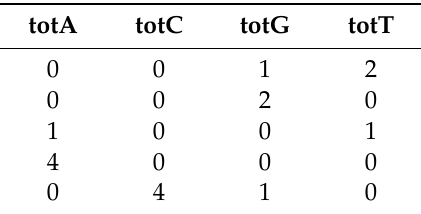
Table 1. Summary of a read stack, showing the number of bases observed in columns (totA, totC, totG, and totT) at each position of the reference genome (represented as sequential rows). The Consensify sequence for this read stack would be TGNAC. totA totC